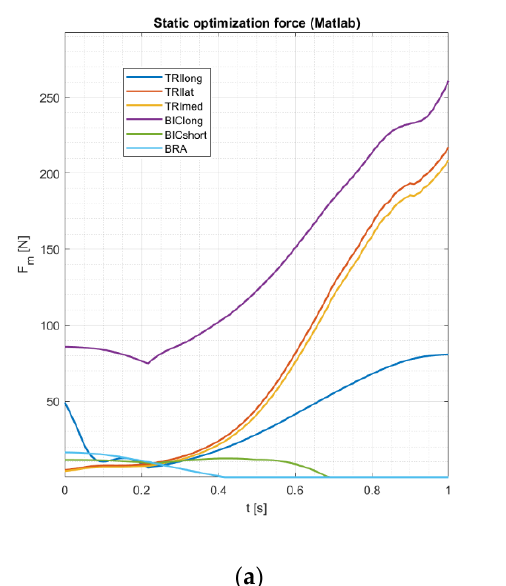
Figure 17. Muscles’ activations with physiological criterion and passive forces: ( a ) Matlab and ( b ) OpenSim.